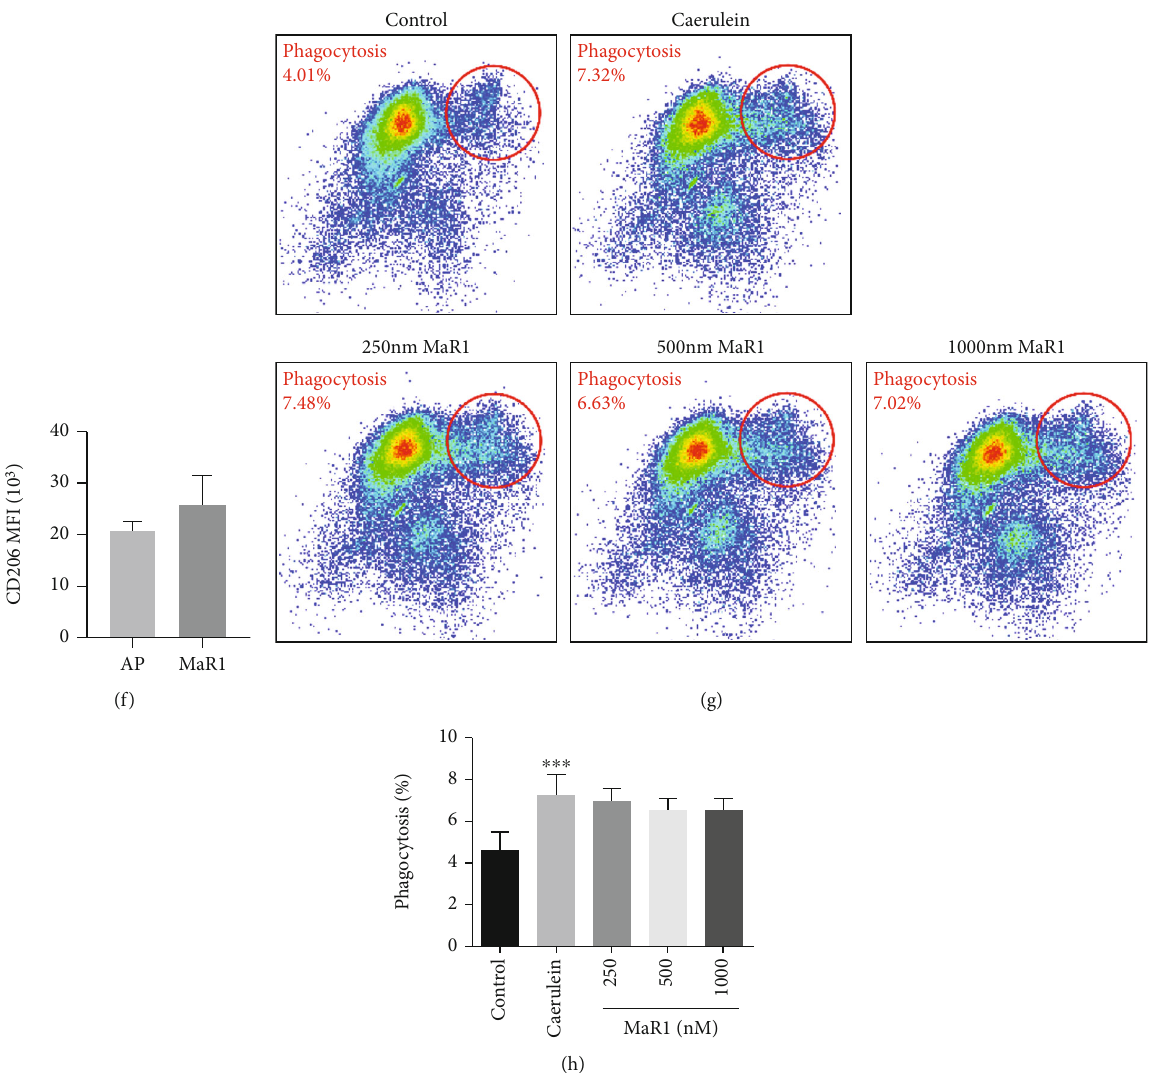
Figure 3: MaR1 inhibited macrophage in fi ltration in the pancreatic tissue. (a) IHC examinations for F4/80 of macrophages in the pancreas in magni fi cation 200x. n ≥ 6 each group. (b, c) Total macrophage counting in the pancreas of the AP and MaR1 groups. (d) Flow cytometry of TNF α for M1 and CD206 for M2 in the pancreas. (e) Mean fl uorescence intensity of TNF α for M1 in fi ltration in pancreas. (f) Mean fl uorescence intensity of CD206 for M2 in fi ltration in the pancreas. n ≥ 4 each group. (g, h) Flow cytometry of BMDM phagocytosis of pancreatic acinar cells and related quanti fi cation. n ≥ 7 each group. ∗∗ P < 0 : 01 , ∗∗∗ P < 0 : 001 vs. the AP or control